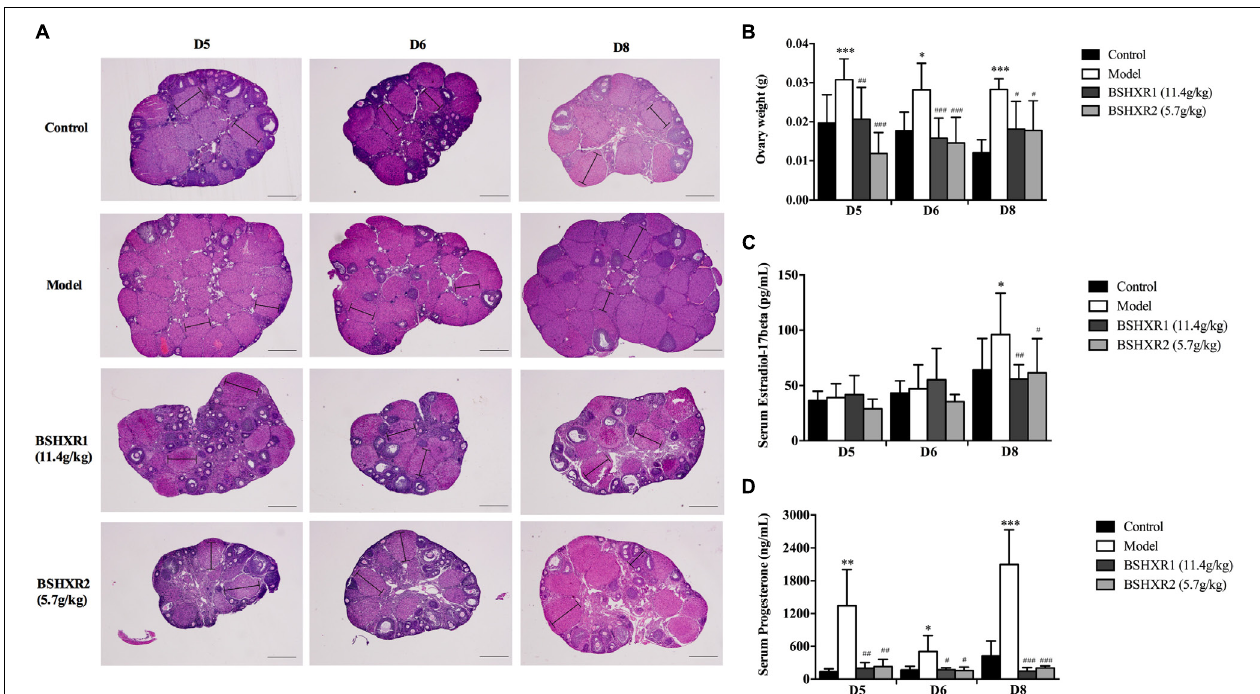
FIGURE 4 | Effect of BSHXR on the morphology of ovary and serum hormones. (A) Morphology analysis of ovary section (HE, × 40), lines indicate maximum diameters of corpus luteum. Bars = 500 µ m. (B) Measurement of bilateral ovary weight on D5, D6, and D8, N = 9–10. (C) Serum estradiol-17 β levels on D5, D6, and D8, N = 8–10. (D) Serum progesterone levels on D5, D6, and D8, N = 8–10. Data represent as mean ± SD. ∗ P < 0.05, ∗∗ P < 0.01, and ∗∗∗ P < 0.001 when compared to control group. # P < 0.05, ## P < 0.01, and ### P < 0.001 when compared to model